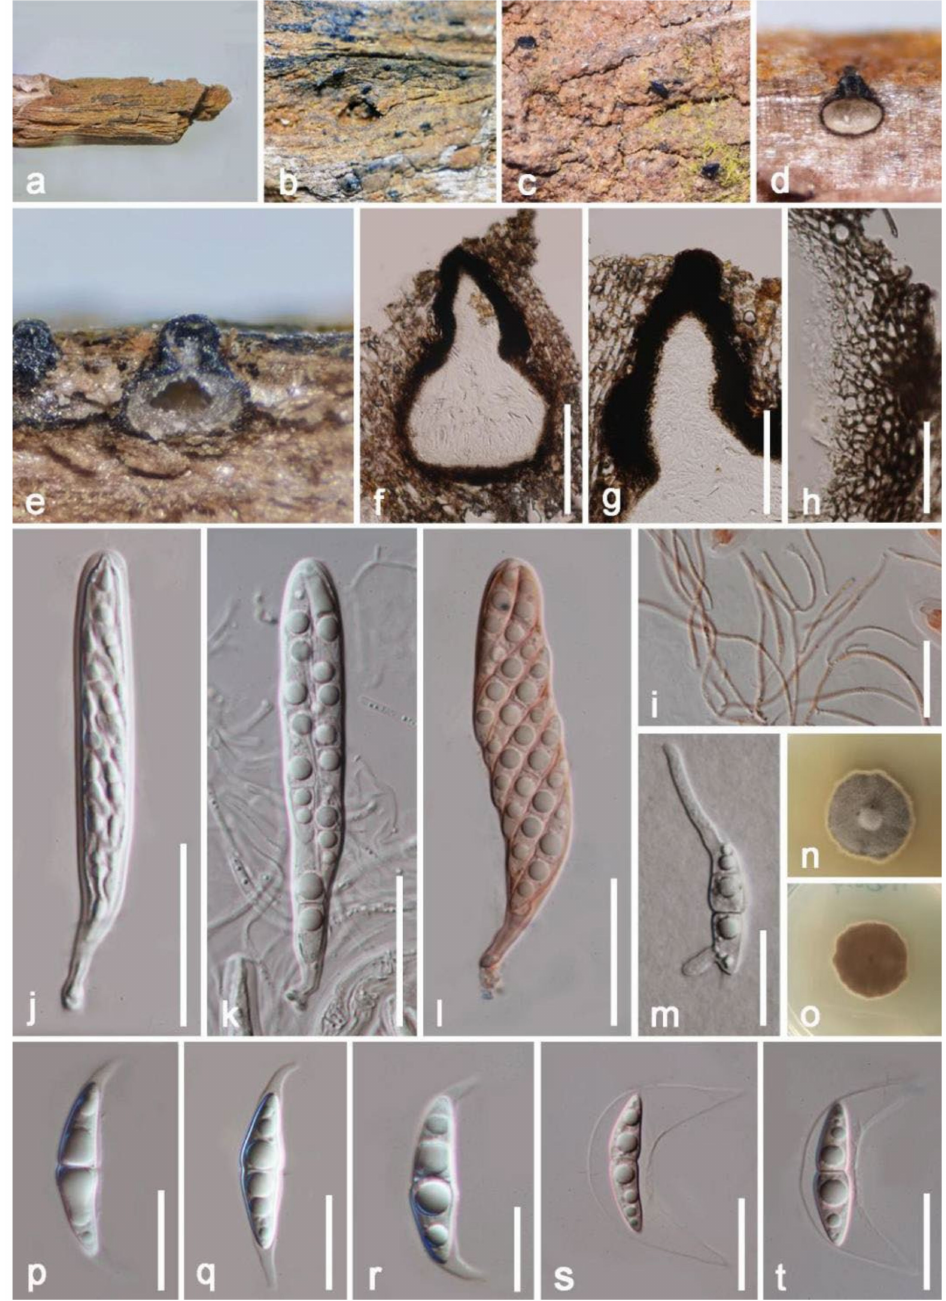
Figure 2. Vaginatispora amygdali (HKAS 122195). ( a ) Appearance on natural substrate; ( b , c ) erumpent neck scattered on host surface; ( d – f ) vertical section of ascomata; ( g ) prolonged neck; ( h ) peridium; ( i ) pseudoparaphyses stained by congo red; ( j , k ) asci; ( l ) asci stained by congo red; ( m ) germinated ascospore; ( n , o ) colony on PDA from above and reverse; ( p – r ) ascospores; ( s , t ) as- cospores stained by congo red. Scale bars: ( f ) = 200 µ m; ( g ) = 100 µ m; ( h , j – l ) = 30 µ m; ( i , m , s , t ) = 20 µ m; ( p – r ) = 15 µ